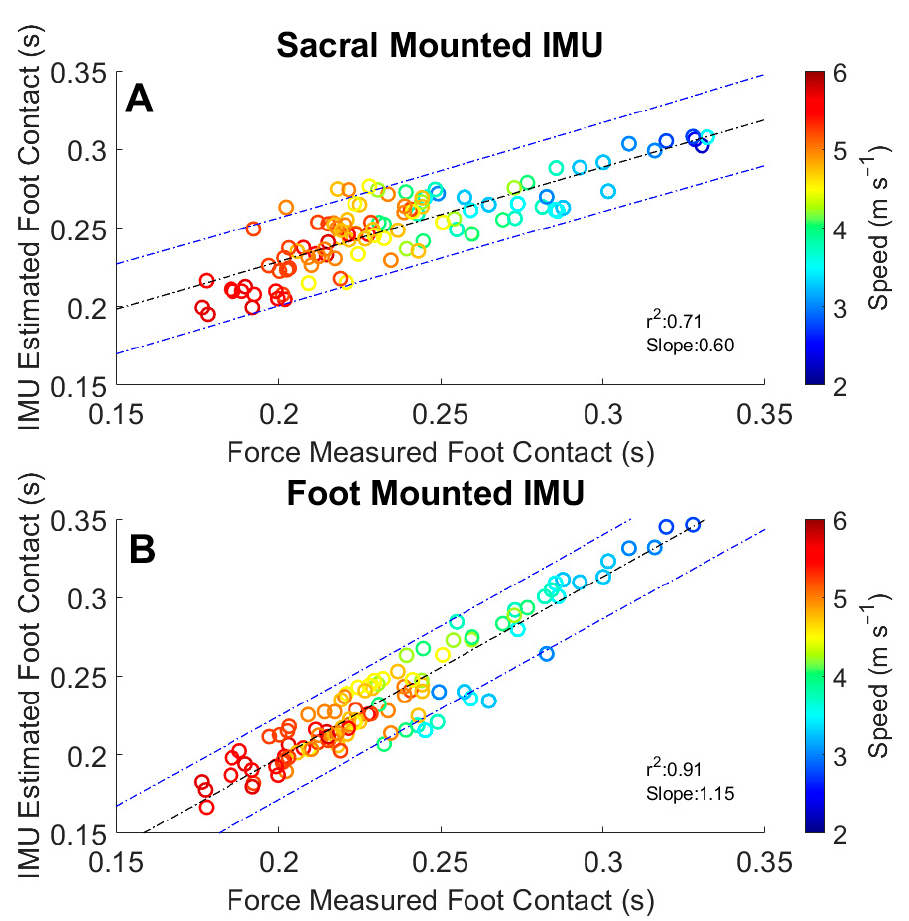
Figure 7. Time differences between the IMU-estimated foot contact and force-measured foot contact: ( A ) data from sacral-mounted IMU; ( B ) data from foot-mounted IMU. Sacral-mounted IMU data generally underestimated foot contact, with a slope of 0.60. Foot-mounted IMU data generally overestimated foot contact duration at a faster speeds slope of 1.15. The foot-mounted IMU was more accurate across the range of speeds for the estimation of foot contact in comparison to the sacral-mounted